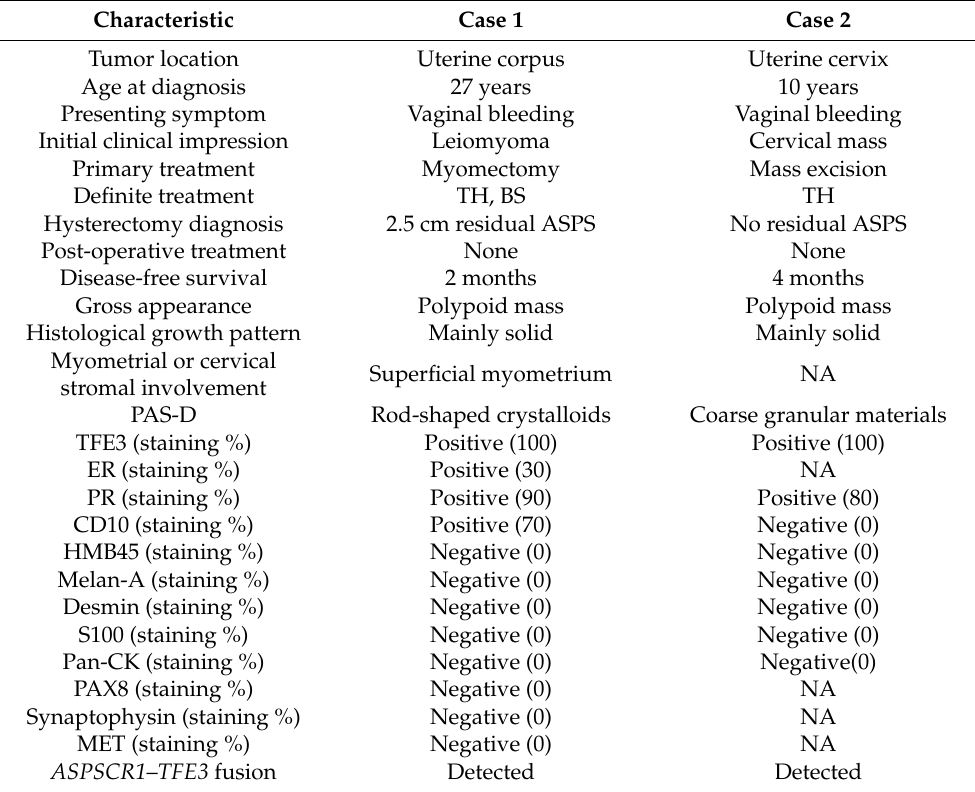
Table 2. Summary of clinicopathological, immunophenotypical, and molecular characteristics of primary uterine alveolar soft part